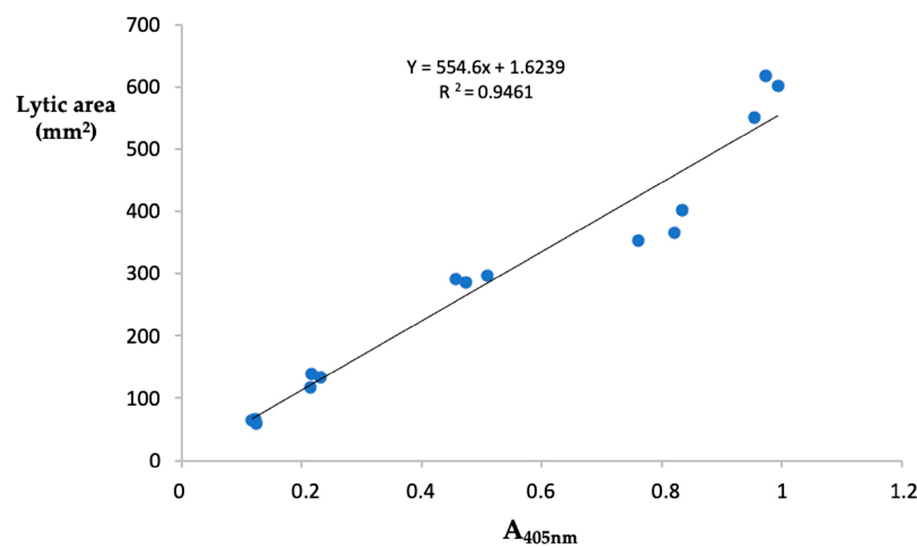
Figure 2. Correlation between fibrin plate assay and spectrophotometric method. Relationship between the absorbance at 405 nm of the released p-nitroanilide from the chromogenic substrates tosyl-Gly-Pro-Lys-p-nitroanilide and the area of lysis on fibrin plate, obtained from the analysis of five different concentrations of plasmin performed in triplicate.